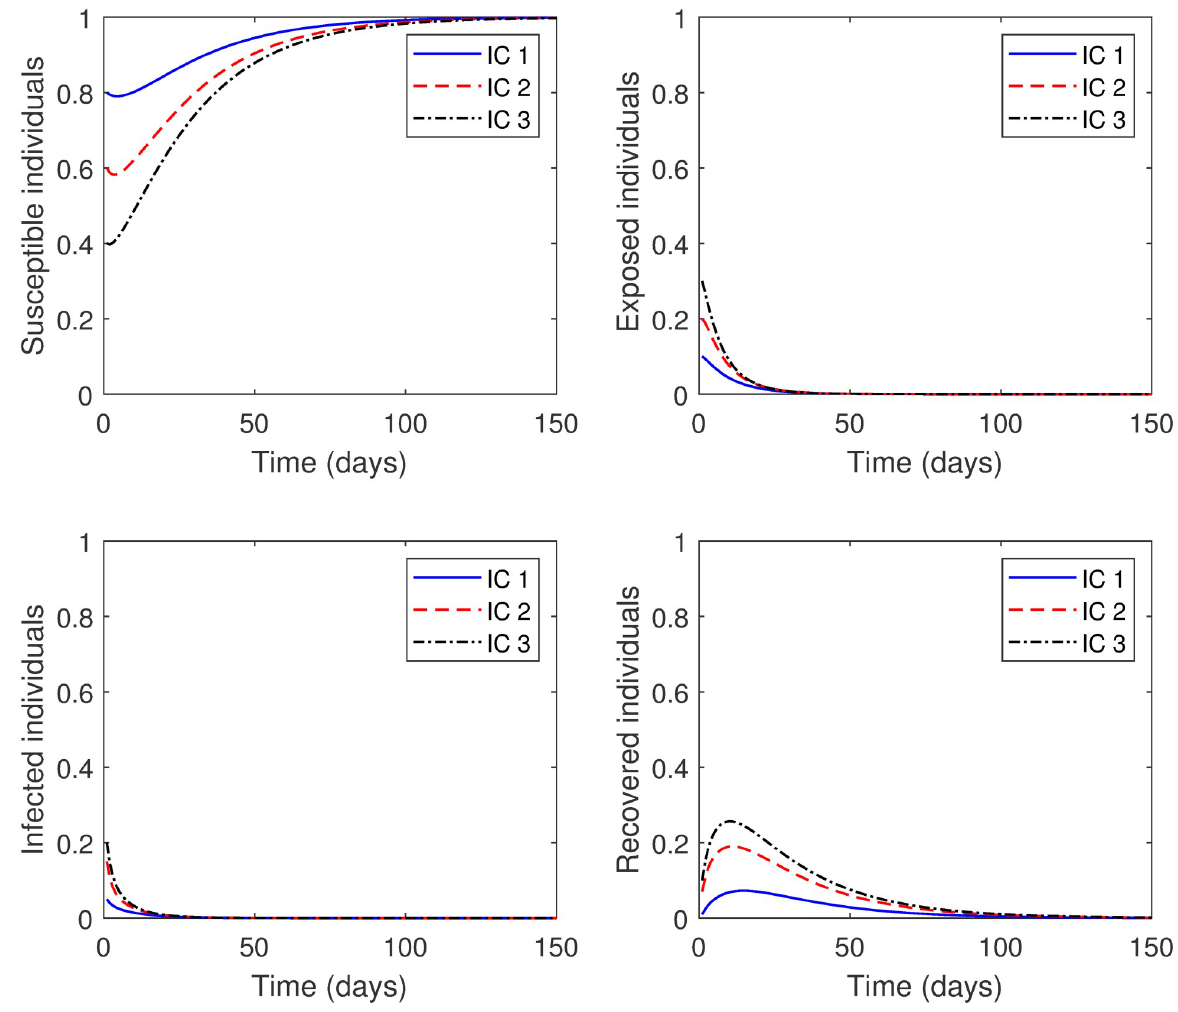
Fig 4. Numerical solution of model (1) with different initial conditions for R